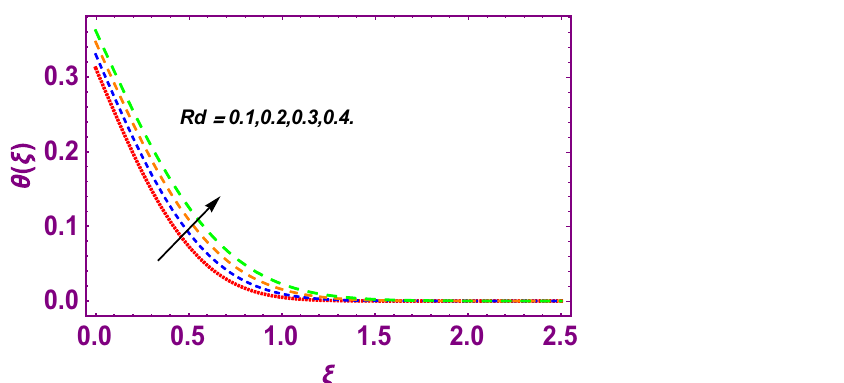
Figure 14. Effect of Rd on θ(ξ) .